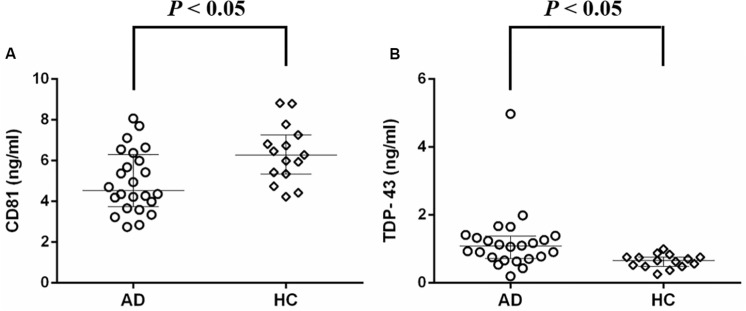
Protein concentrations of plasma neuronal-derived exosomes detected with ELISA. (A) Median CD81 level was lower in patients with AD compared to HCs. (B) Median normalized TDP-43 concentration was higher in patients with AD compared to HCs. AD, Alzheimer’s disease; HC, healthy control.